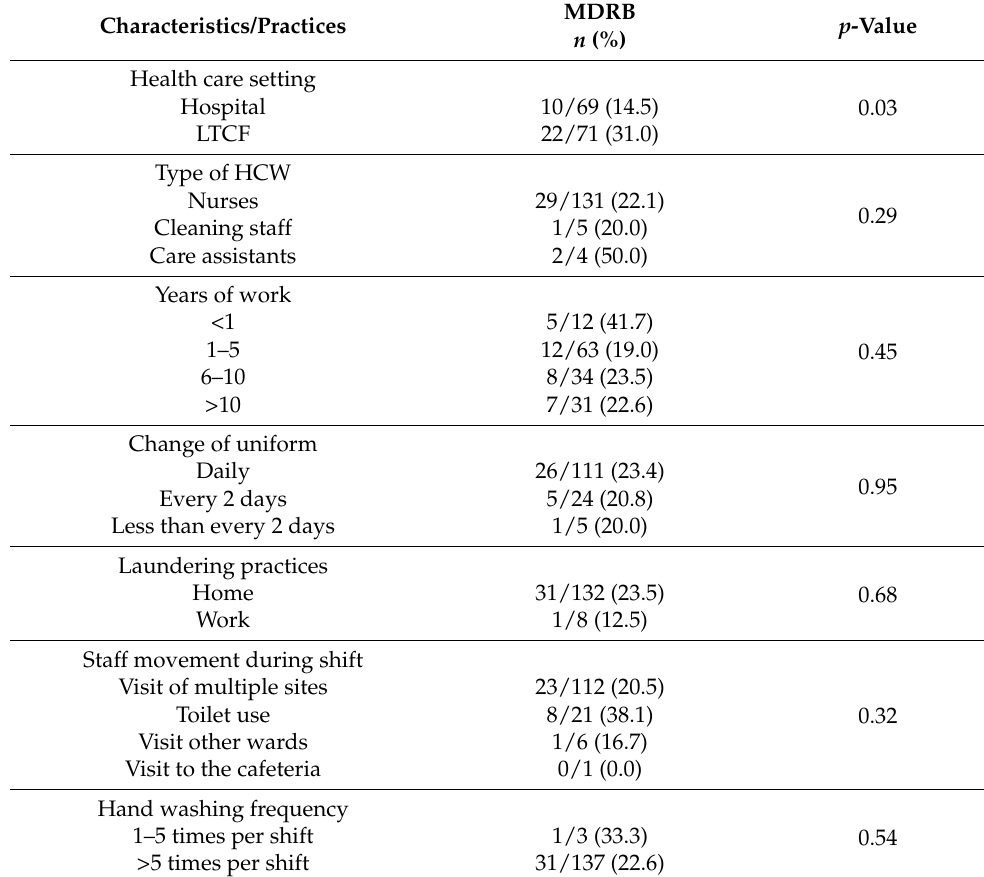
Table 3. HCW characteristics and practices in association with MDRB isolation ( n =